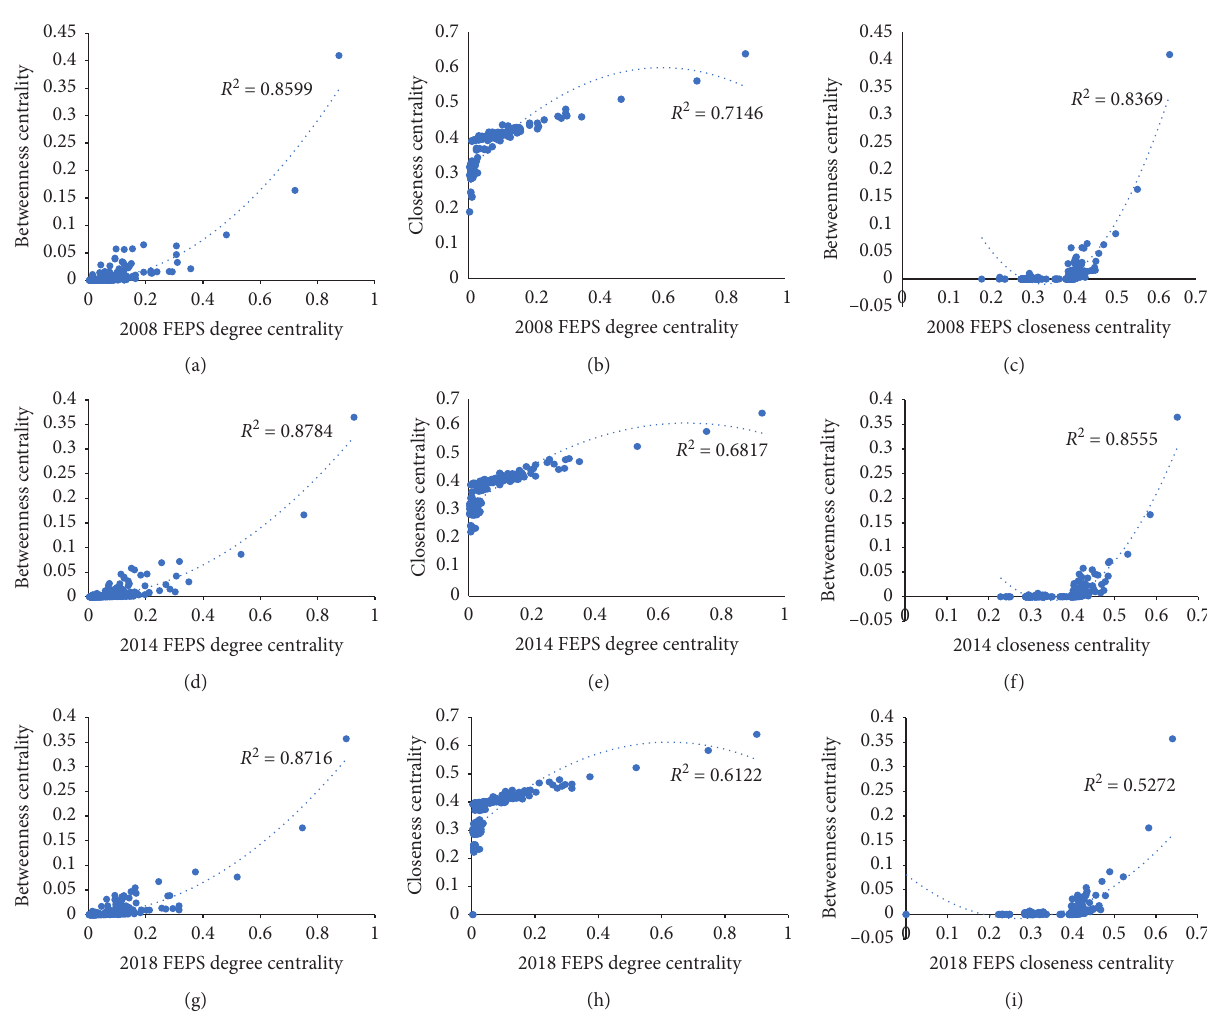
Figure 4: Correlation of degree centrality (DC), closeness centrality (CC), and betweenness centrality (BC) in 2008. Table 7: Top 20 Air Cargo Accessibility airports in the FEPS Networks (units: million ton-